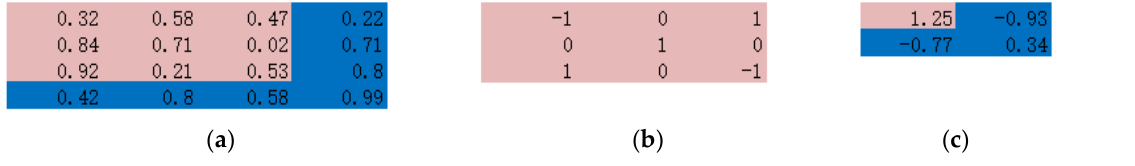
Figure 1. Demonstration of the convolution operation. ( a ) a 4 × 4 array, ( b ) a 3 × 3 filter and its weights, and ( c ) the resulting output array.